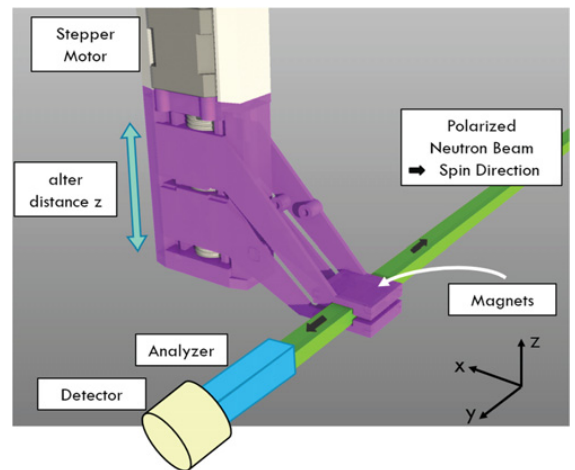
Figure 6. Illustration of the polarimeter experiment. The spin direction of polarized neutrons is altered by the spin flipper and then analyzed to observe modulations in the detected